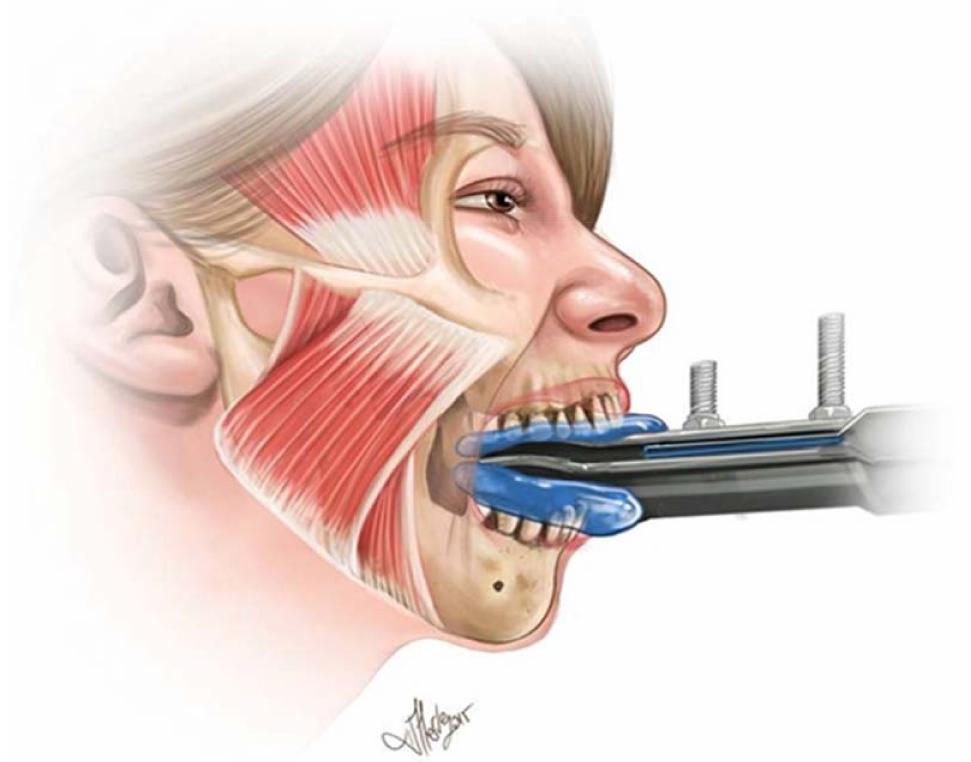
Figure 1. The illustration depicts the biting platform and the position of the subject. The mold illustrated as blue, allowed all teeth to be involved. A force transducer was placed close to the base of the tungsten plates which corresponds to the right most of the